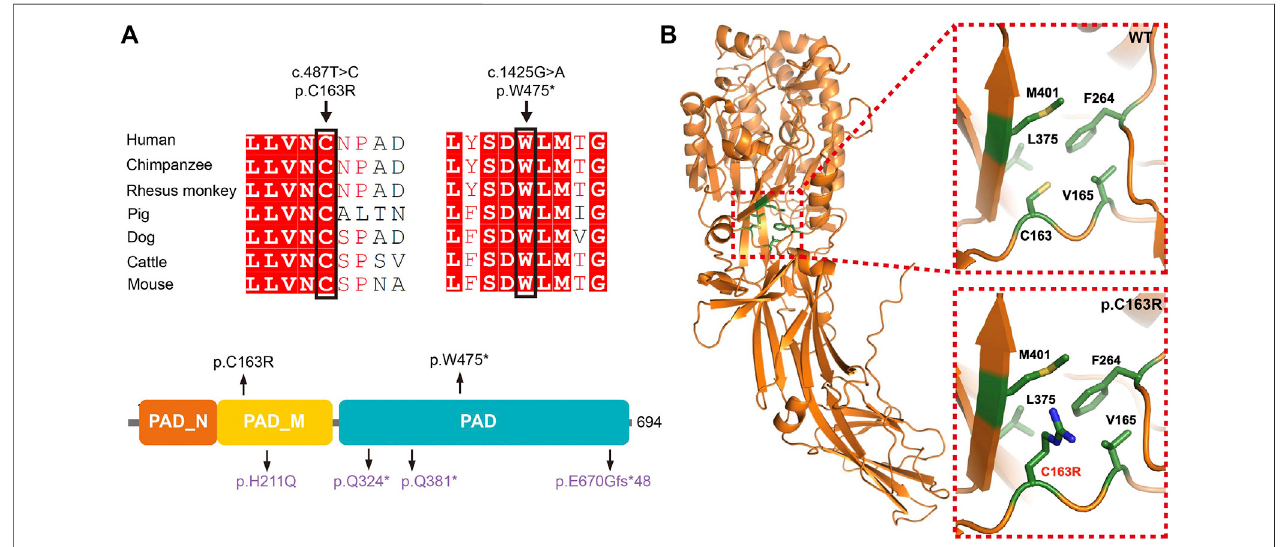
FIGURE2| Location,conservation,andstructureanalysisofthemutantresiduesofPADI6. (A) Conservationanalysis,andlocationofthemutantresiduesidenti fi ed inourstudies.Variantsidenti fi edinthisstudyarepresentedinblack,andvariantsidenti fi edinourpreviousstudyarepresentedinpurple. (B) Structurepredictionofthep. Cys163Arg